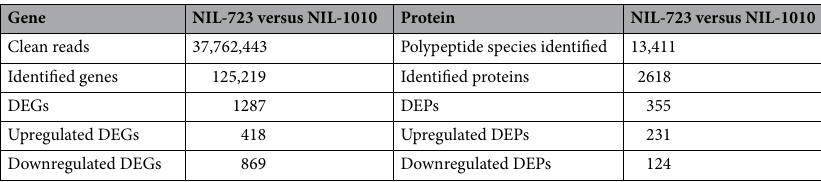
Table 2. Results of identification genes and quantitative proteins.